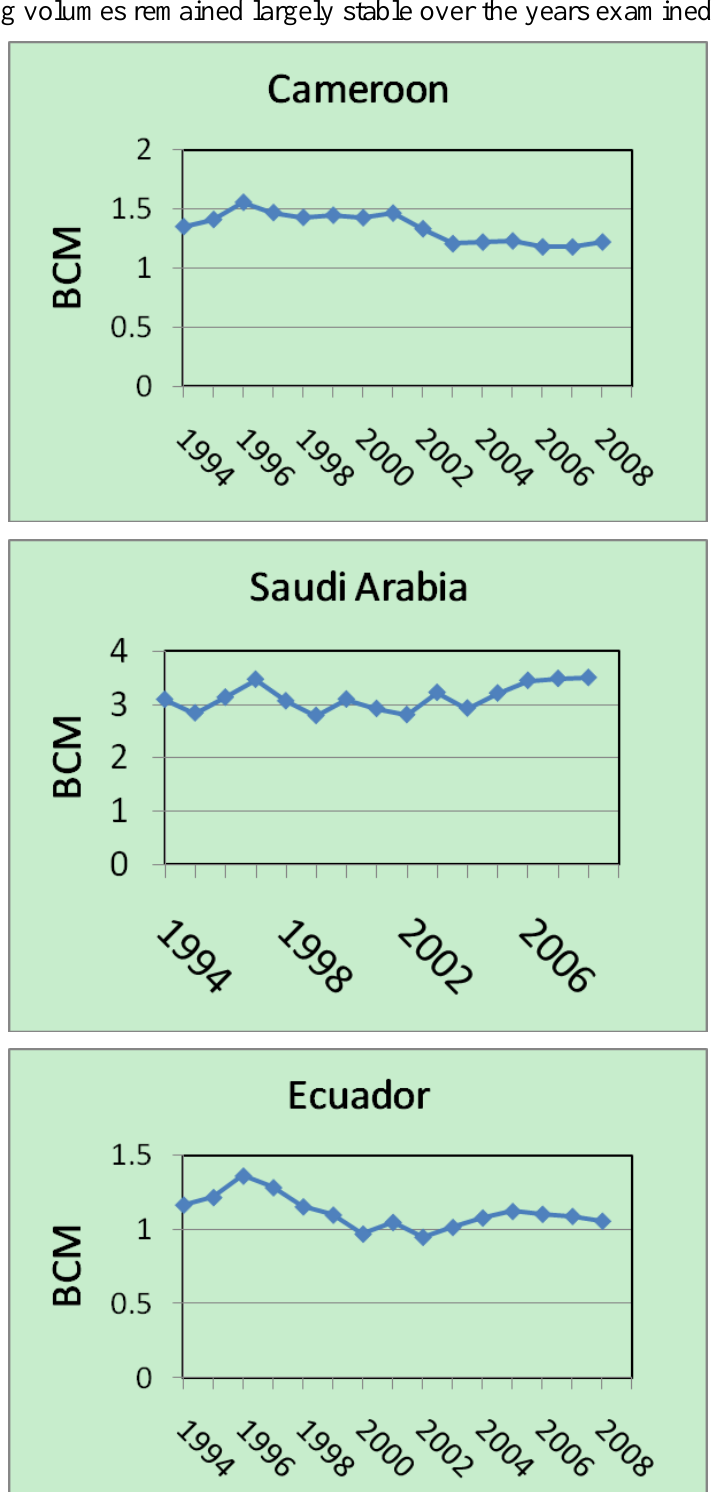
Figure 13 . Cameroon, Saudi Arabia, and Ecuador were three of the nine countries or areas where gas flaring volumes remained largely stable over the years